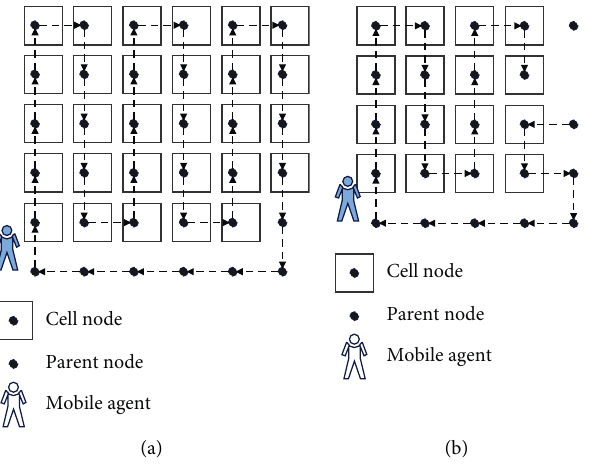
Figure 11: Multi-MA traversal